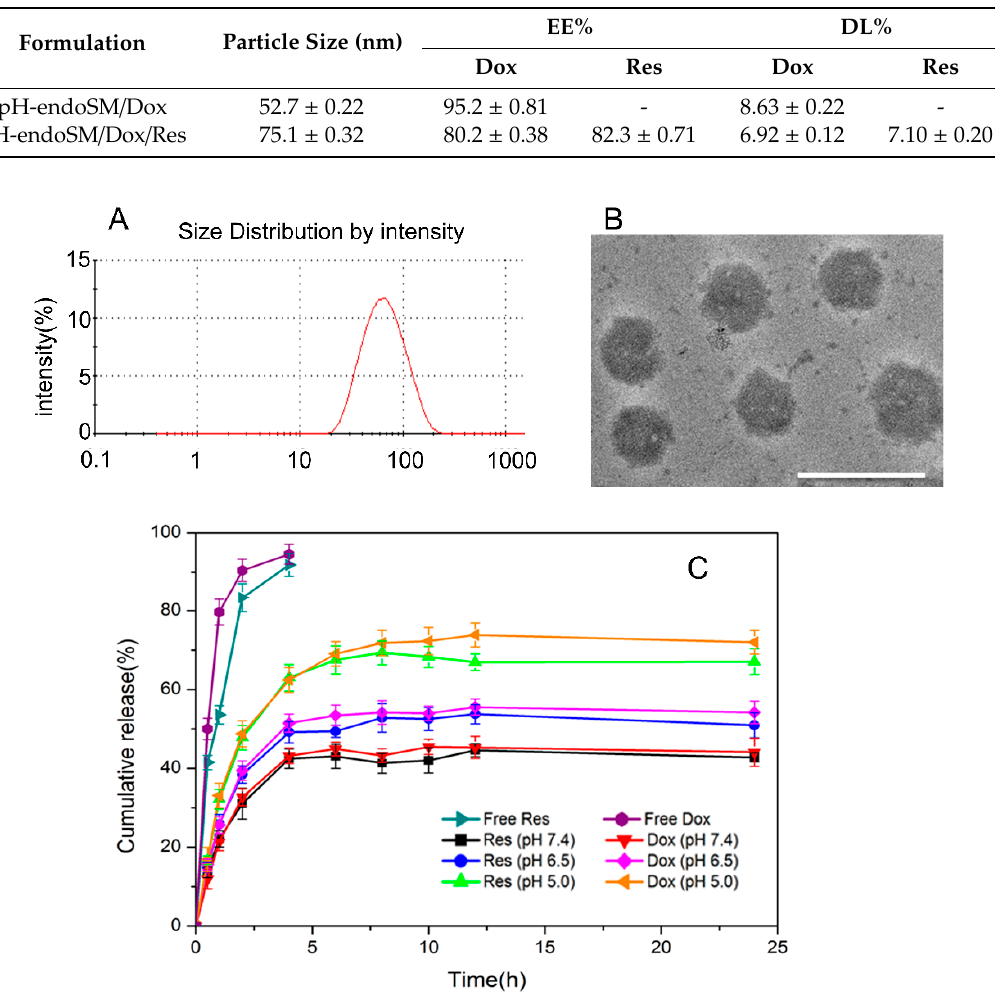
Figure 2. Particle size distribution ( A ) and transmission electron microscopy (TEM) image of pH-endoSM / Dox / Res micelles. Scale bar represents 100 nm ( B ). In vitro release profiles of Dox and Res from the pH-endoSM / Dox / Res micelles in phosphate-bu ff ered saline (PBS) (pH 7.4, 6.5 and 5.0) at 37 ◦ C. The data are presented as means (%) ± SD from three independent experiments ( C ).